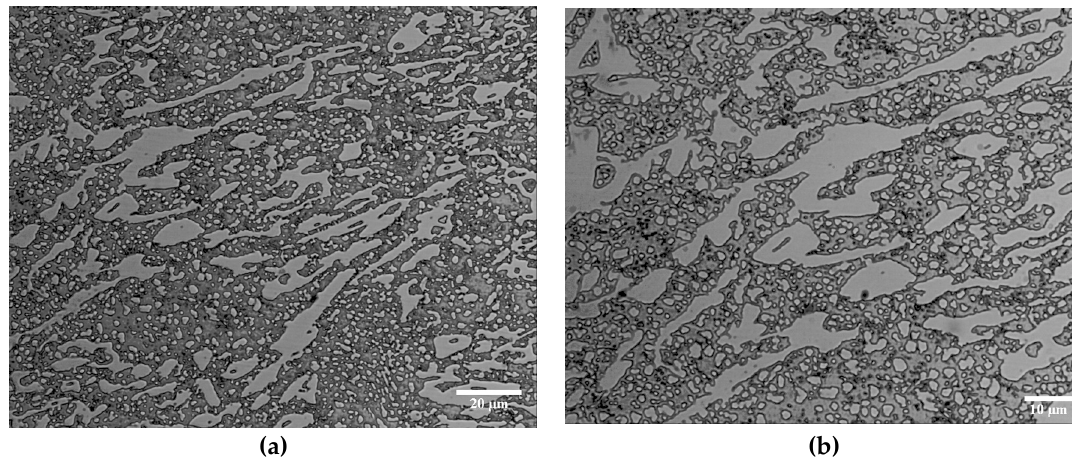
Figure 2. Microstructure following the softening treatment: ( a ) 400 × magnification; ( b ) 600 × magnification. Table 4. Hardness and weight loss in the erosive wear test.